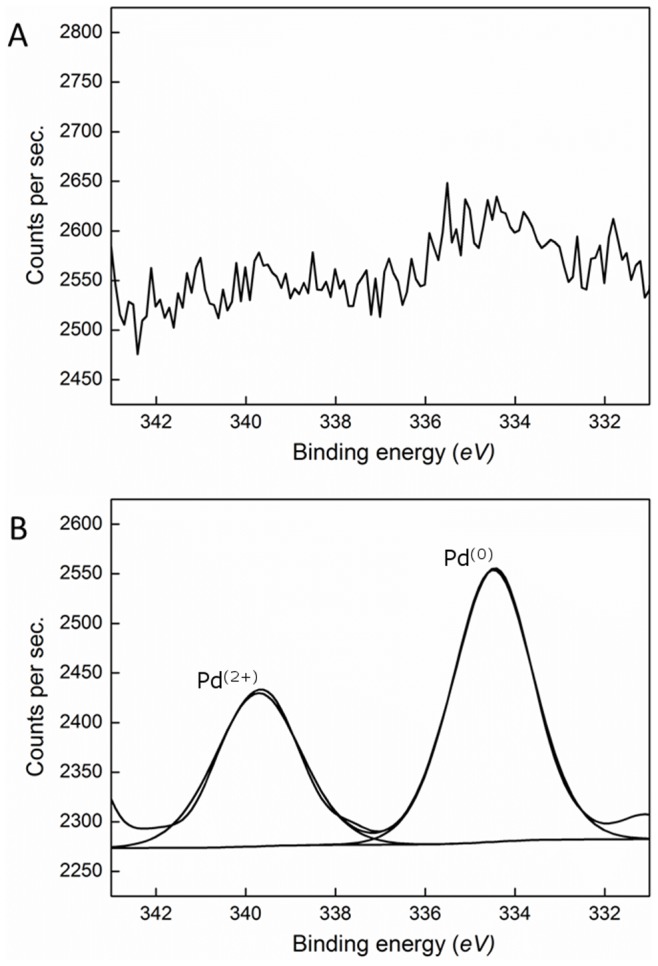
XPS spectra showing: a) undosed control plant, b) plant dosed with palladium for 24 h.